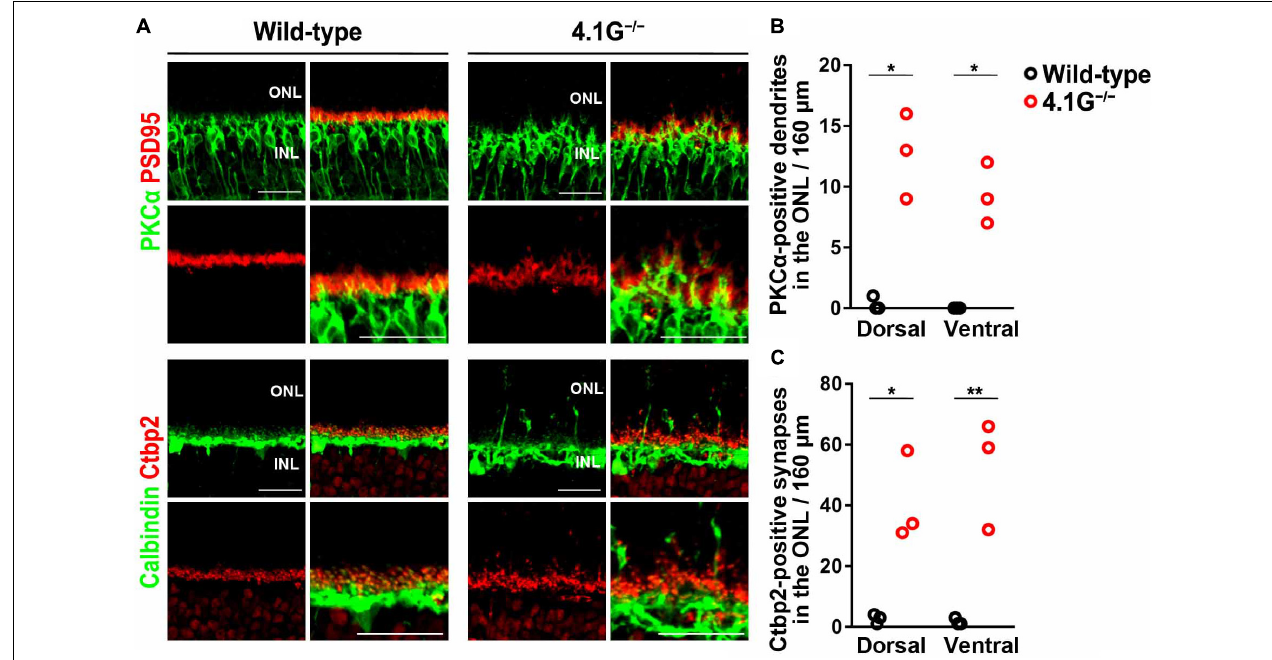
FIGURE 7 | Mislocalization of photoreceptor synaptic terminals observed in 4.1G − / − retinas. (A) Retinal sections of the wild-type control and 4.1G − / − mice aged 2 months old were immunostained using anti-PSD95, anti-Ctbp2, anti-Calbindin, and anti-PKC α antibodies. (B,C) Extended rod bipolar cell dendrites and ectopic photoreceptor terminals were counted. Student t -test (* p < 0.05, ** p < 0.01). Error bars, mean ± SD ( n = 3 mice). ONL, outer nuclear layer; OPL, outer plexiform layer; INL, inner nuclear layer. Scale bars, 25 µ